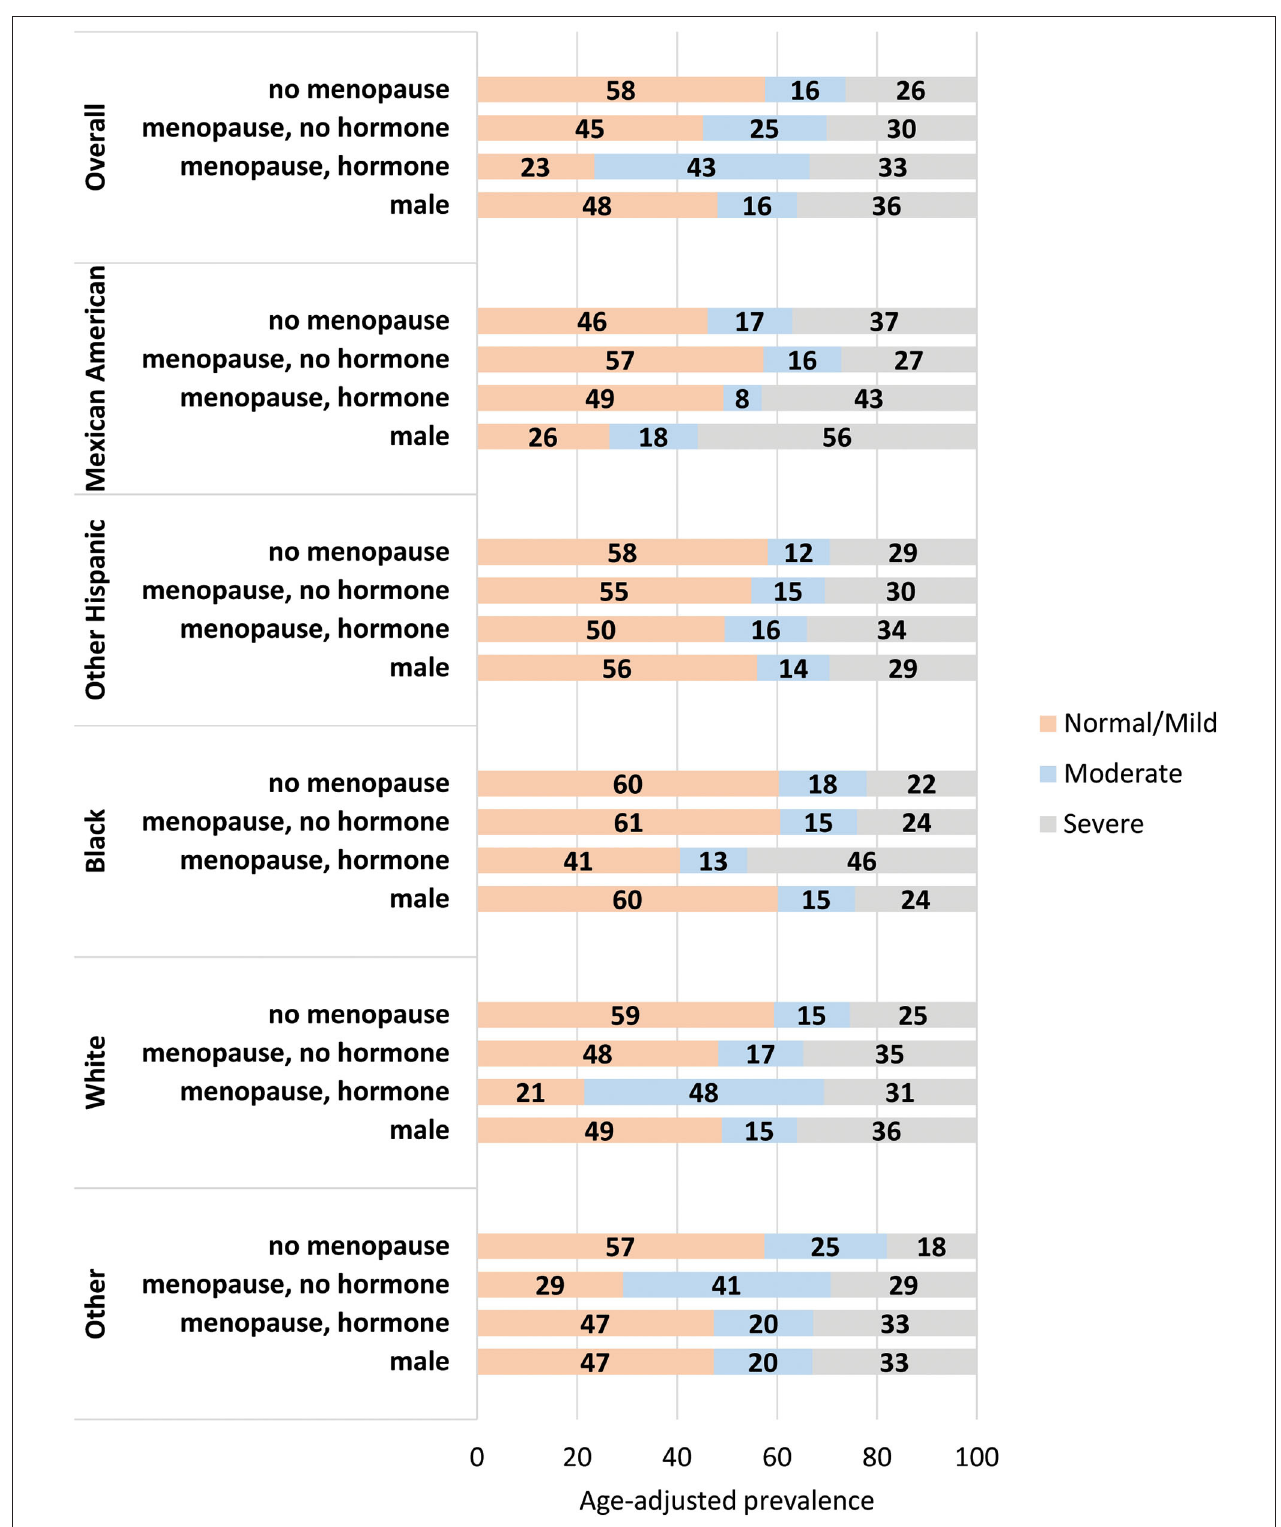
FIGURE 2 | Age-adjusted prevalence of stages of NAFLD by gender and menopausal status. The age-adjusted prevalence of each stage of NAFLD within each gender/menopause group for the population overall (top) and stratified by racial/ethnic group. Data labels denote the prevalence of each stage.